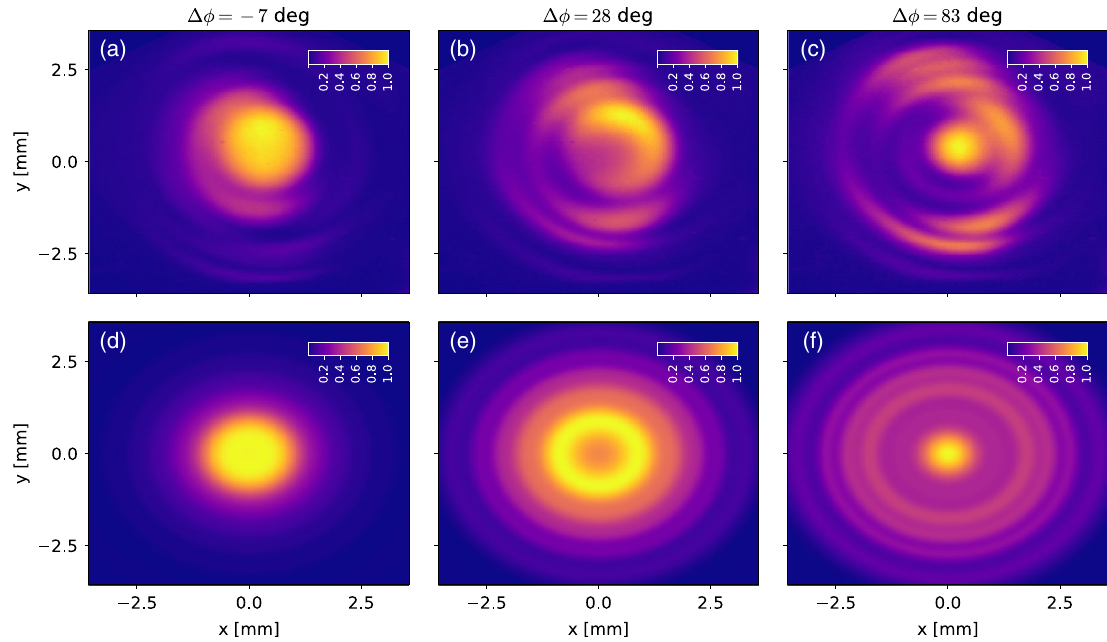
. (a) the phasing enhances the 6